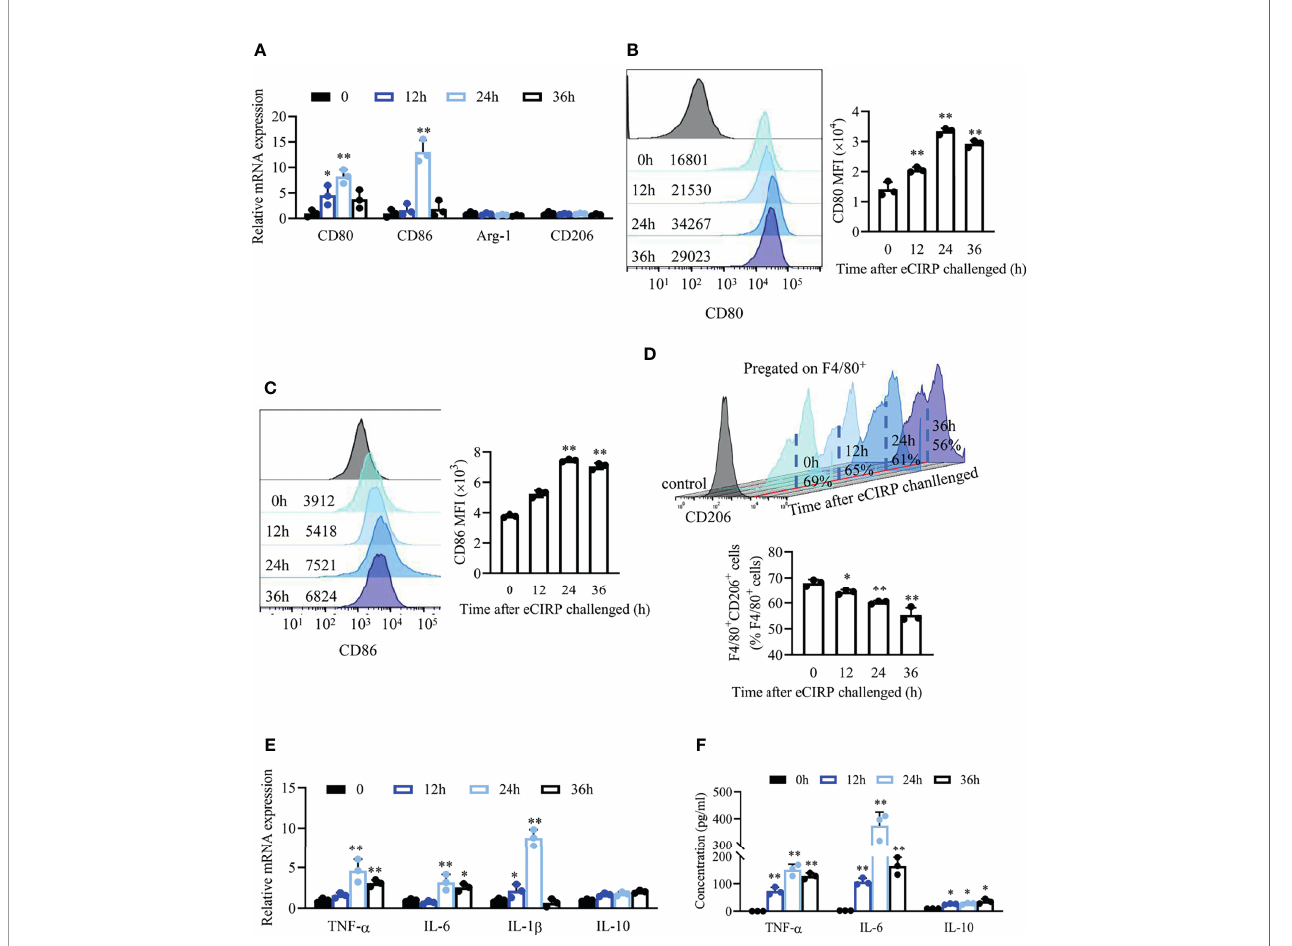
FIGURE 2 | eCIRP impaired/restrained M2 macrophage polarization and induced a pro-in fl ammatory response. (A) A qPCR assay was conducted to evaluate the mRNA expression of CD80, CD86, Arg1, and CD206 in BMDMs after eCIRP treatment for 0, 12, 24, and 36 h (n = 3). The MFI of CD80 (B) and CD86 (C) and the percentage of CD206 + macrophages in BMDMs (D) were measured by FACS at indicated time after eCIRP administration (n = 3). (E) A qPCR assay was conducted to evaluate the mRNA expression of TNF- a , IL-6, IL-1 b , and IL-10 in BMDMs after eCIRP treatment at the indicated time (n = 3). (F) The concentrations of TNF- a , IL-6, and IL-10 in the supernatant at indicated time after eCIRP administration were measured. Data are representative of at least two independent experiments. Results were expressed as mean ± SD. * P < 0.05, ** P < 0.01 compared to 0 h group. Statistics: One-way ANOVA with Tukey ’ s post-hoc test for multiple comparisons (A – F) . eCIRP, extracellular cold-inducible RNA-binding protein; PCR, Polymerase Chain Reaction; MFI, mean fl uorescence intensity; BMDM, bone marrow derived macrophage; FACS, fl uorescence activated cell